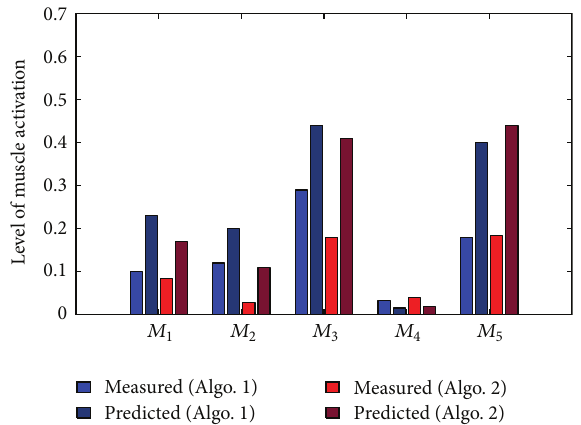
Figure 13: Level of muscle activation (Target: 𝑀 2 ).